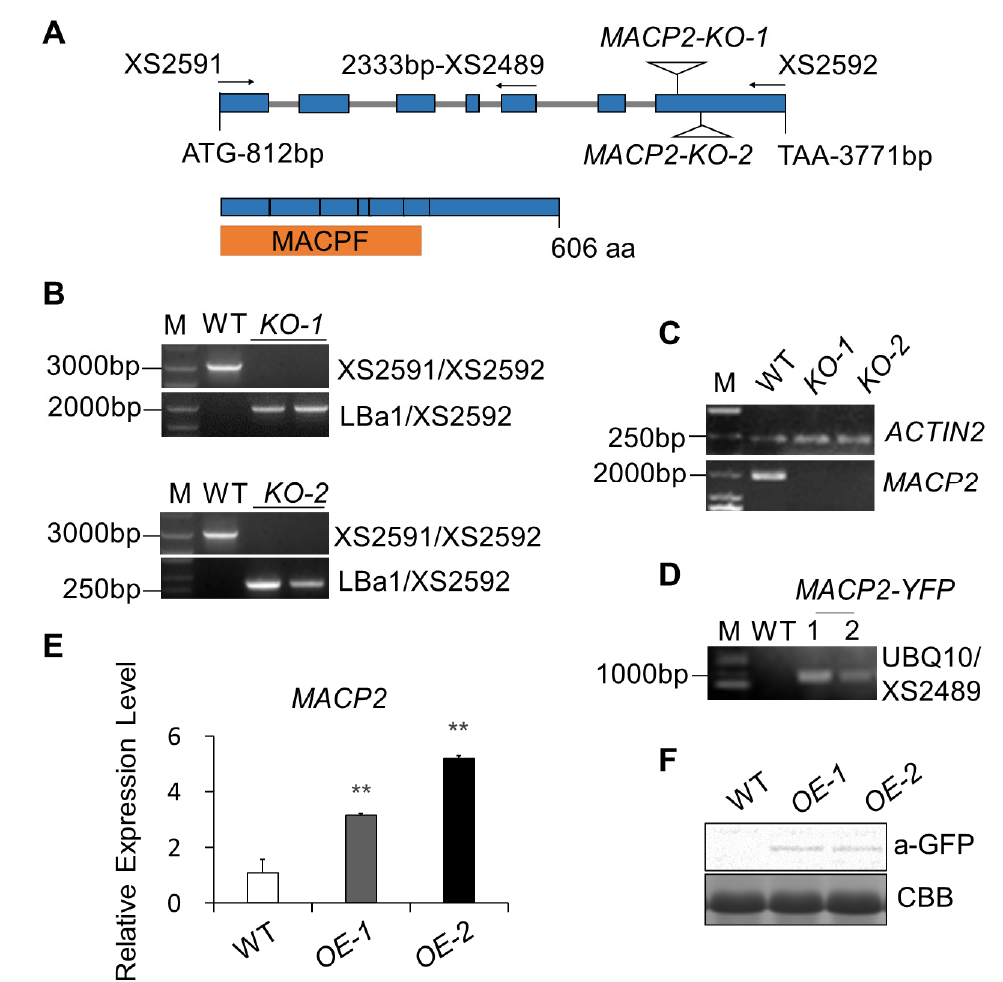
Figure 1. Characterization of T-DNA insertional mutants and transgenic overexpression lines in MACP2. ( A ) Schematic depicting the MACP2 gene, indicating the T-DNA insertion site of MACP2-KO-1 and MACP2-KO-2. ( B ) Identification of MACP2-KOs via PCR. The full-length MACP 2 was amplified with primer pair XS2591 and XS2592. The length-contained T-DNA sequence was amplified via primer pair LBa1 and XS2592 in KO-1 , and KO-2 . ( C ) Semiquantitative PCR of MACP2 in WT and MACP2-KOs . The full-length MACP2 was amplified with primer pair XS2591 and XS2592. The ACTIN2 was amplified with primer pair ACTIN2-F and ACTIN2-R. ( D ) Identification in DNA level of MACP2-YFP transgenic plants. MACP2 CDS was cloned into pFGC-RCS binary vector then the expression cassette of MACP2-YFP was inserted into the Arabidopsis genome. UBQ10 and XS2489 were derived from the pFGC-RCS plasmid and MACP2 CDS, respectively. ( E ) Identification in RNA level of MACP2-YFP transgenic plants. Transcriptional level of MACP2 in MACP2-OE-1 and MACP2-OE-2 upregulated 3–5 times as that in wild-type. The data represent means from three independent repeats. Statistical differences were identified using Student’s t test. ** p < 0.01. ( F ) Identification in protein level of MACP2-YFP transgenic plants. Anti-GFP was used to recognize the specific YFP tag. CBB represented Coomassie blue staining.